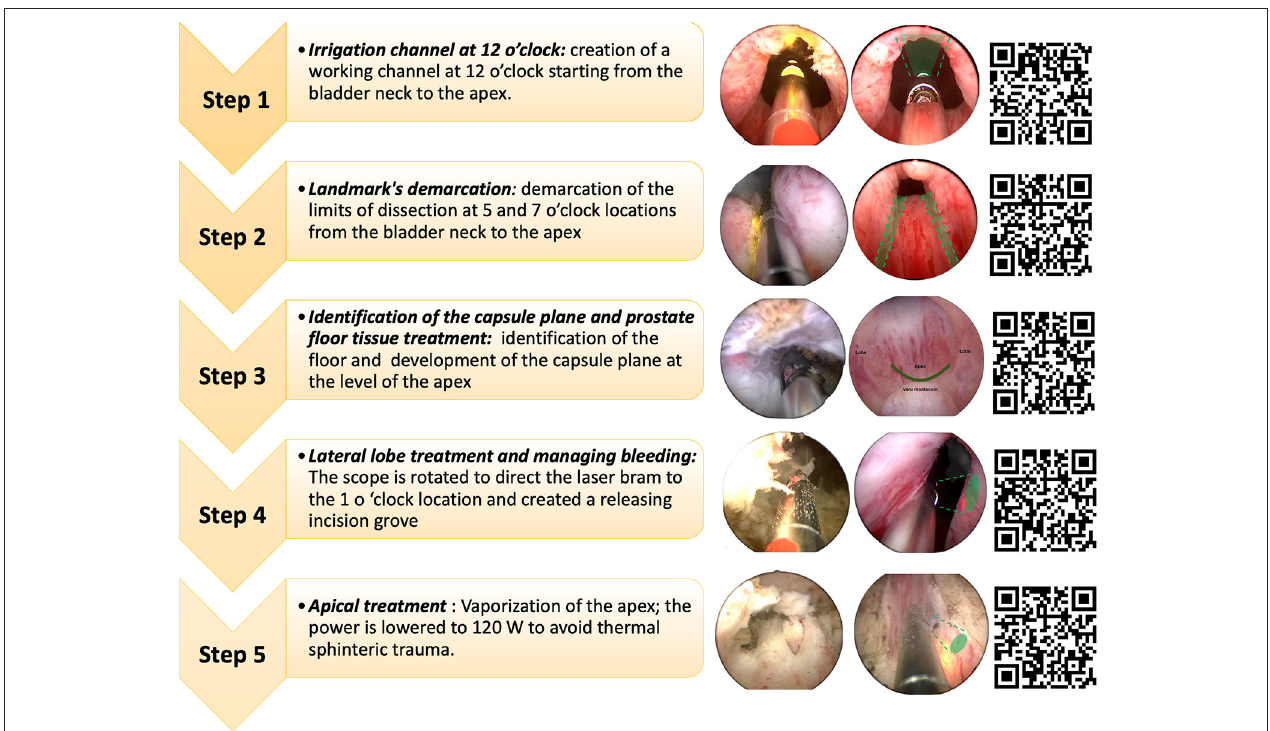
FIGURE 1 | Surgical steps of anatomic photopvaporization of the prostate